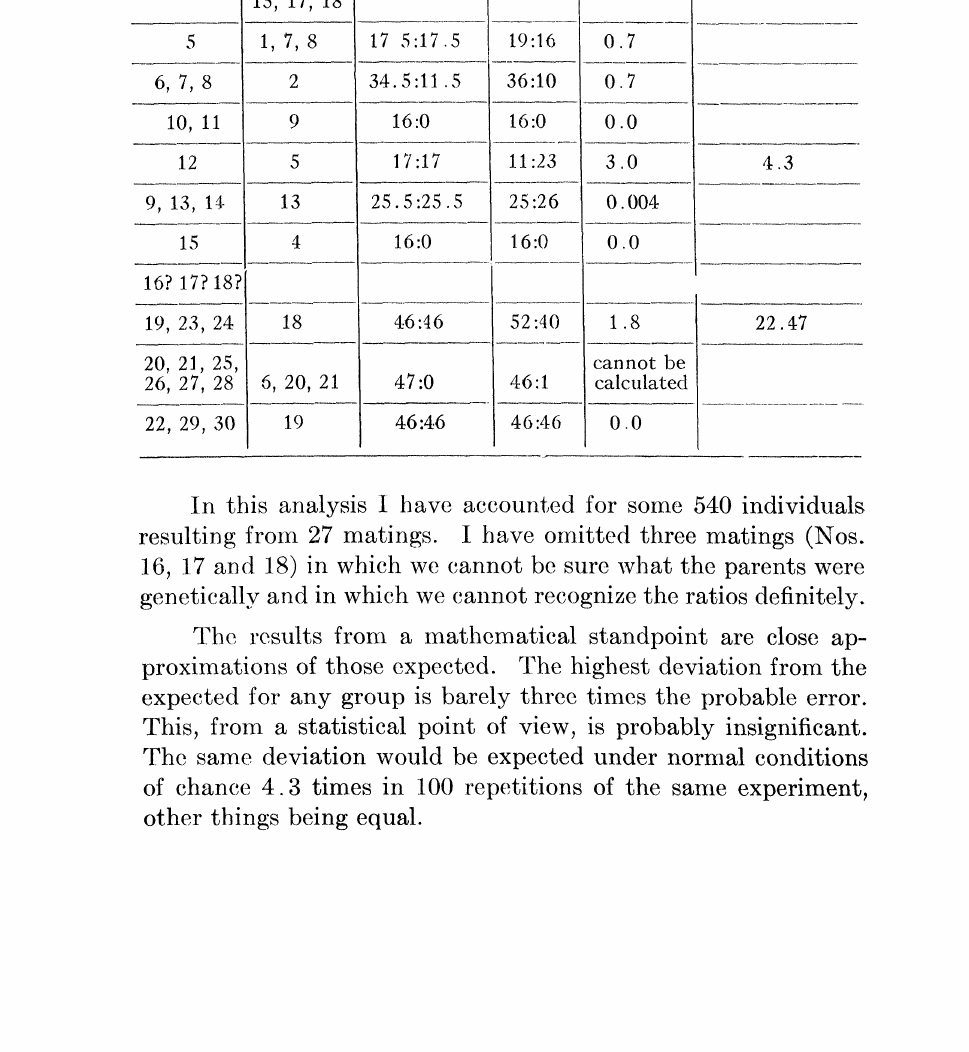
Probable occur- ence of such de- viations due to chance alone during 100 repe- titions of the same experiment, other